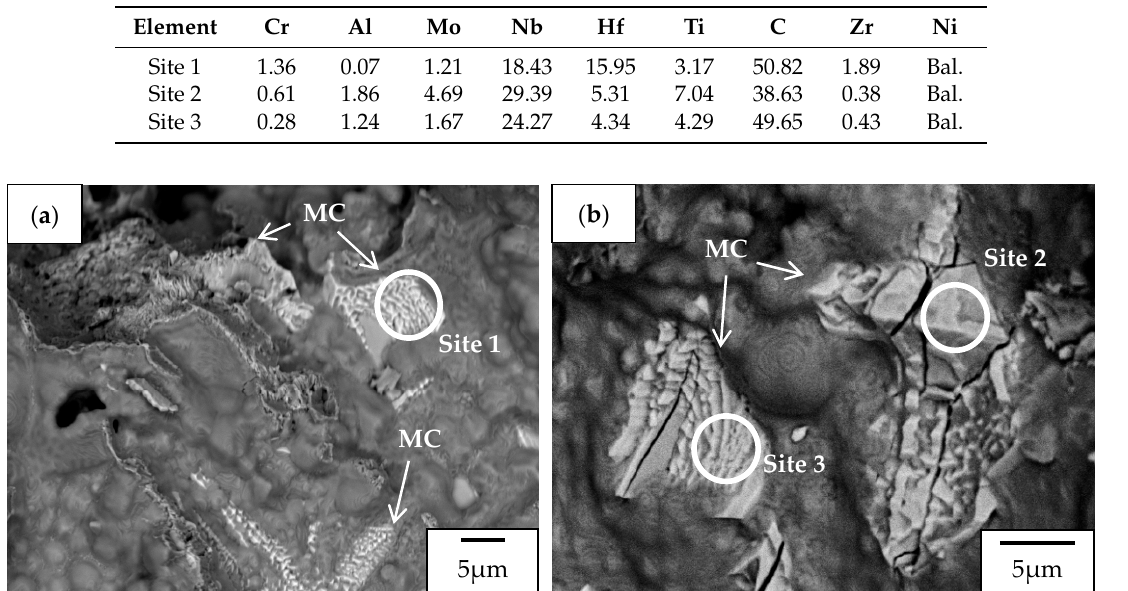
Figure 8. SEM fractographs: ( a ) solidified droplet features covered by final solidification products; ( b ) eutectic microconstituents associated with liquation cracking.